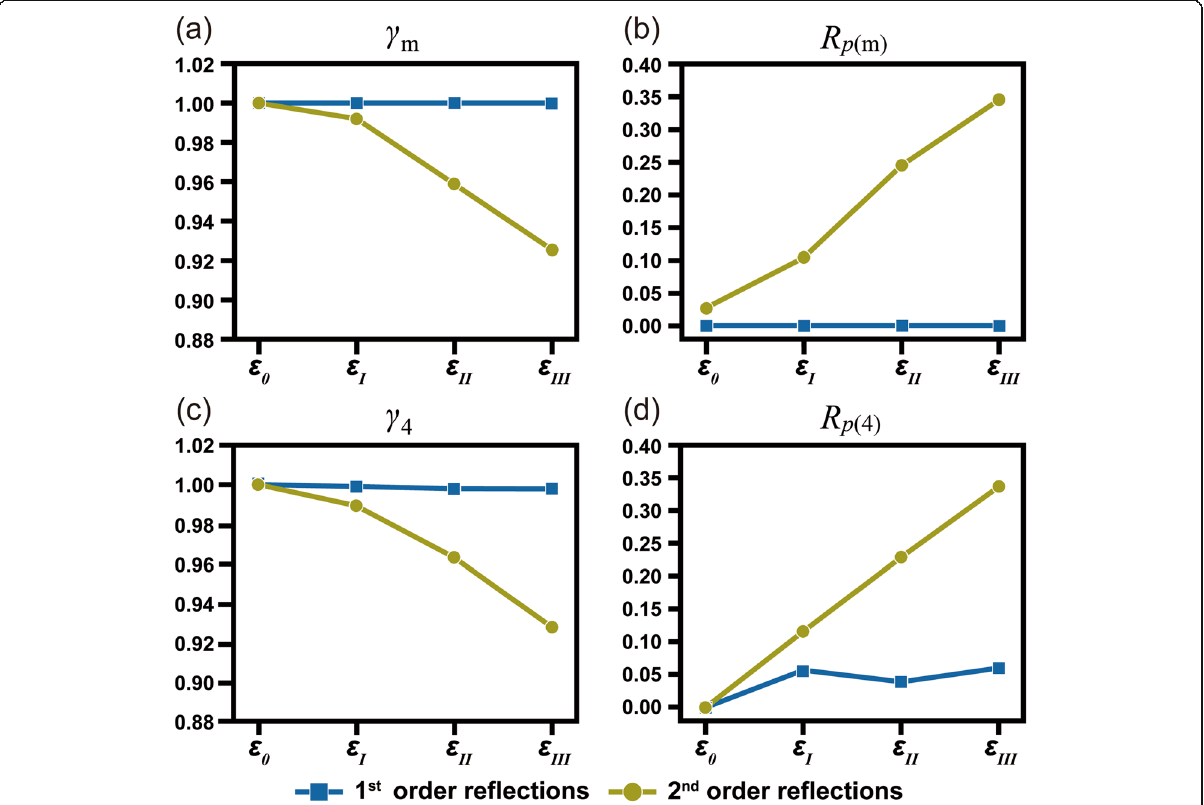
Fig. 2 Symmetry quantification for mirror and 4-fold rotational symmetry recorded in the simulated CBED patterns for ε 0(0%, 0%, 0%) , ε I(0.5%, 0.5%, − ε ε 0.25%) , II(1%, 1%, − 0.5%) , III(2%, 2%, − 1%) . The symmetry elements are respectively quantified based on